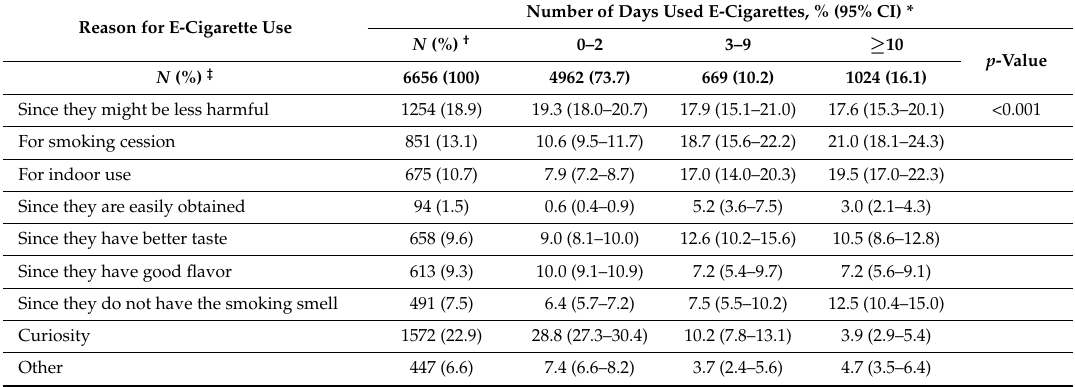
Table 3. Frequency of e-cigarette use according to reason for e-cigarette use among ever e-cigarette users of Korean adolescents ( N =